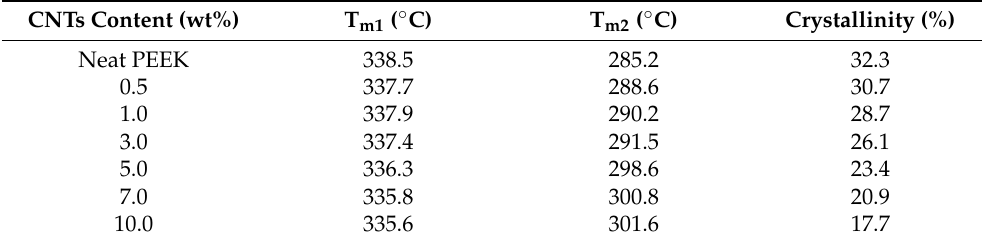
Table 5. Crystallization parameter of the PEEK/CNTs composites after